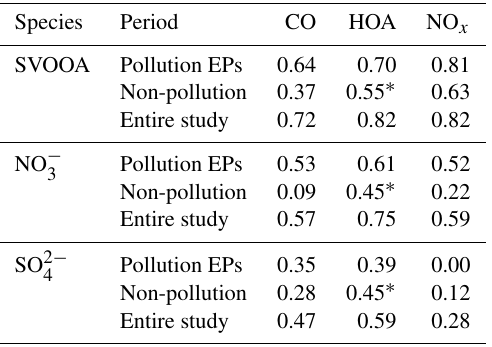
∗ Pearson correlations involving HOA for non-pollution periods may have non-negligible uncertainty since HOA concentration in non-pollution periods is near the method detection limit (MDL) of the ToF-ACSM for